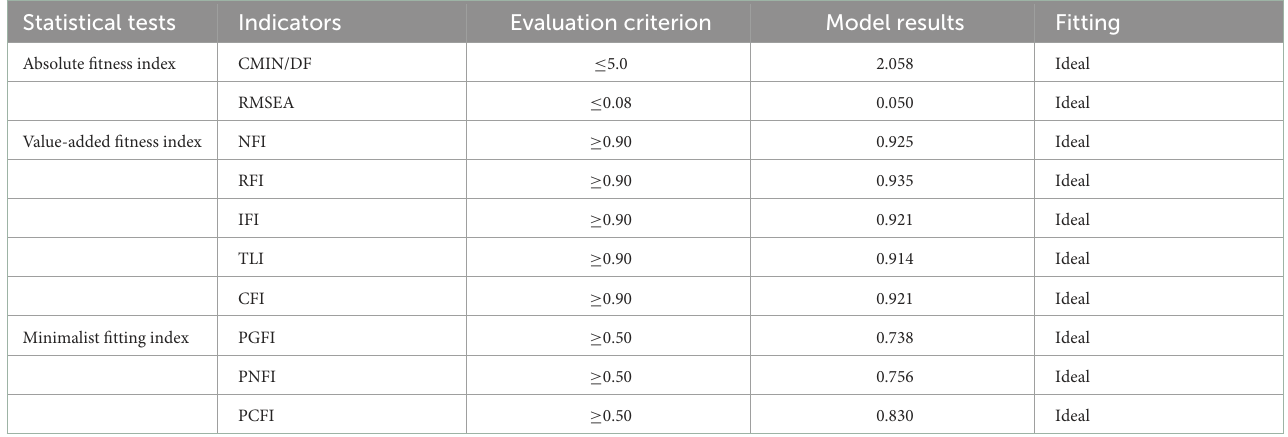
TABLE 4 Model fitting index